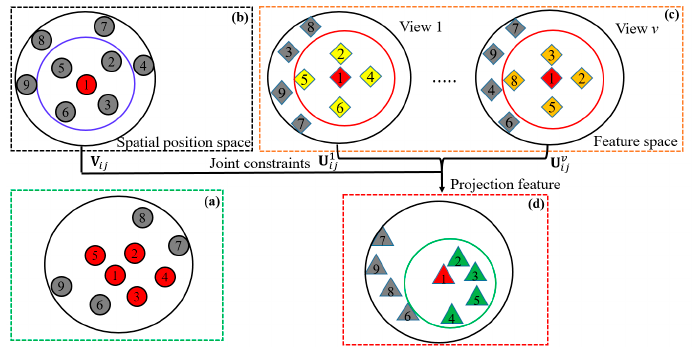
Figure 2. The schematic diagram of feature space and spatial position space joint constraints. ( a ) ground truth, ( b ) 5 neighbor points of p 1 in spatial position space, ( c ) 5 neighbor points of point p 1 for different view features in feature space, ( d ) the projection results (subspace features) with the joint constraints of spatial position space and feature space. Note that different numbers represent different point clouds. Different colors represent different classes. The red point labeled 1 is the selected point p 1 .